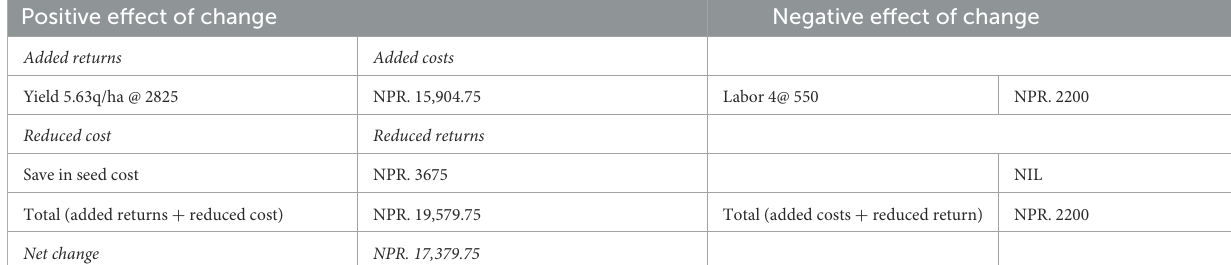
TABLE 4 Scenario 2: partial budget of RH-10 for spring season. Positive effect of